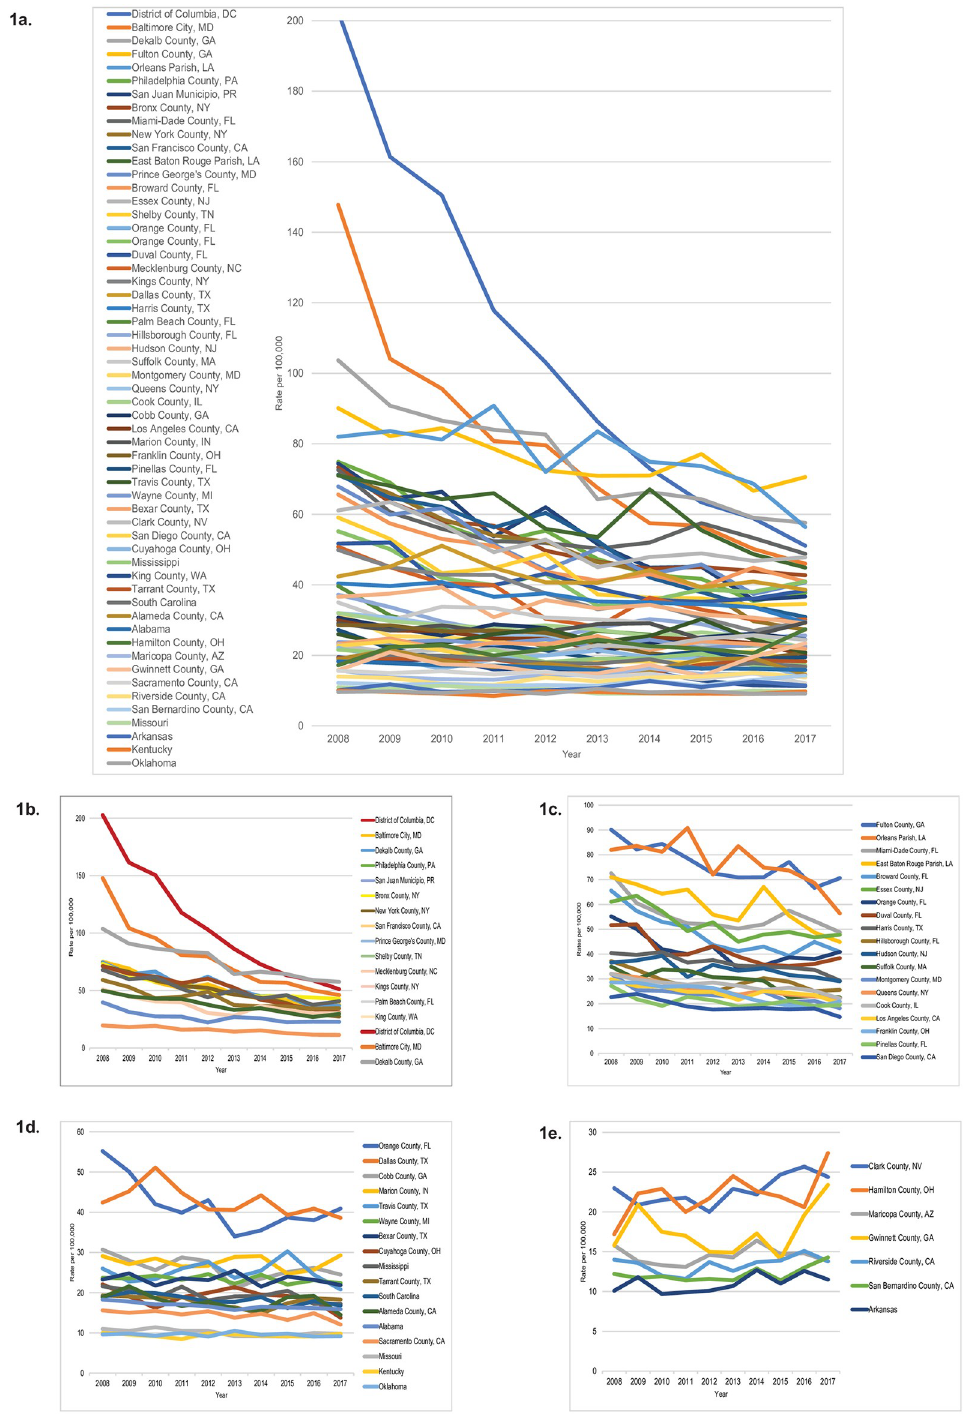
Fig 1. Rates per 100,000 of newly diagnosed HIV cases in US hotspots, 2008–2017. a. All hotspots. b. Hotspots with largest declines in AAPC ( < -5). c. Hotspots with moderate declines in AAPC (-5 to -2.5). d. Hotspots with smallest declines in AAPC (-2.5 to 0.0). e. Hotspots with increasing AAPC ( > 0.0). Footnote. The scale of the y axis differs in each graph to enhance the visualization of differences in trends.